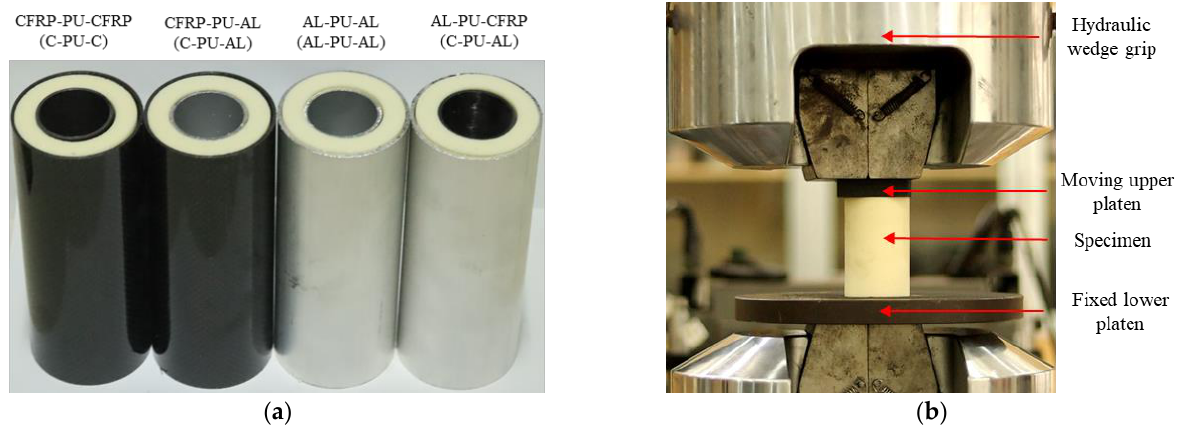
Figure 1. Preparation of specimens and quasi-static compression tests. ( a ) Four foam-filled hybrid structures; ( b ) quasi-static compression test configuration.